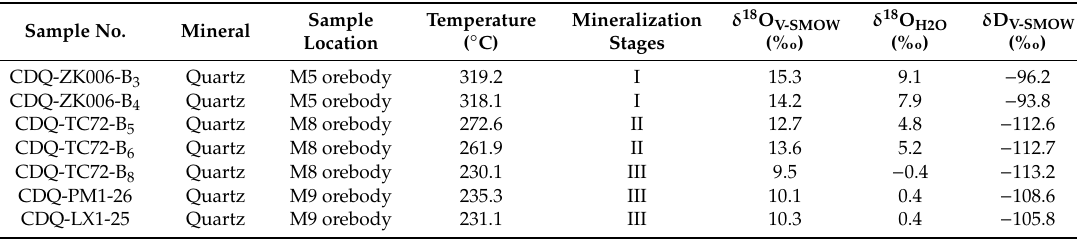
Table 3. The hydrogen and oxygen isotope compositions of the fluid inclusion of stage I, II and III of the Chuduoqu Pb-Zn-Cu